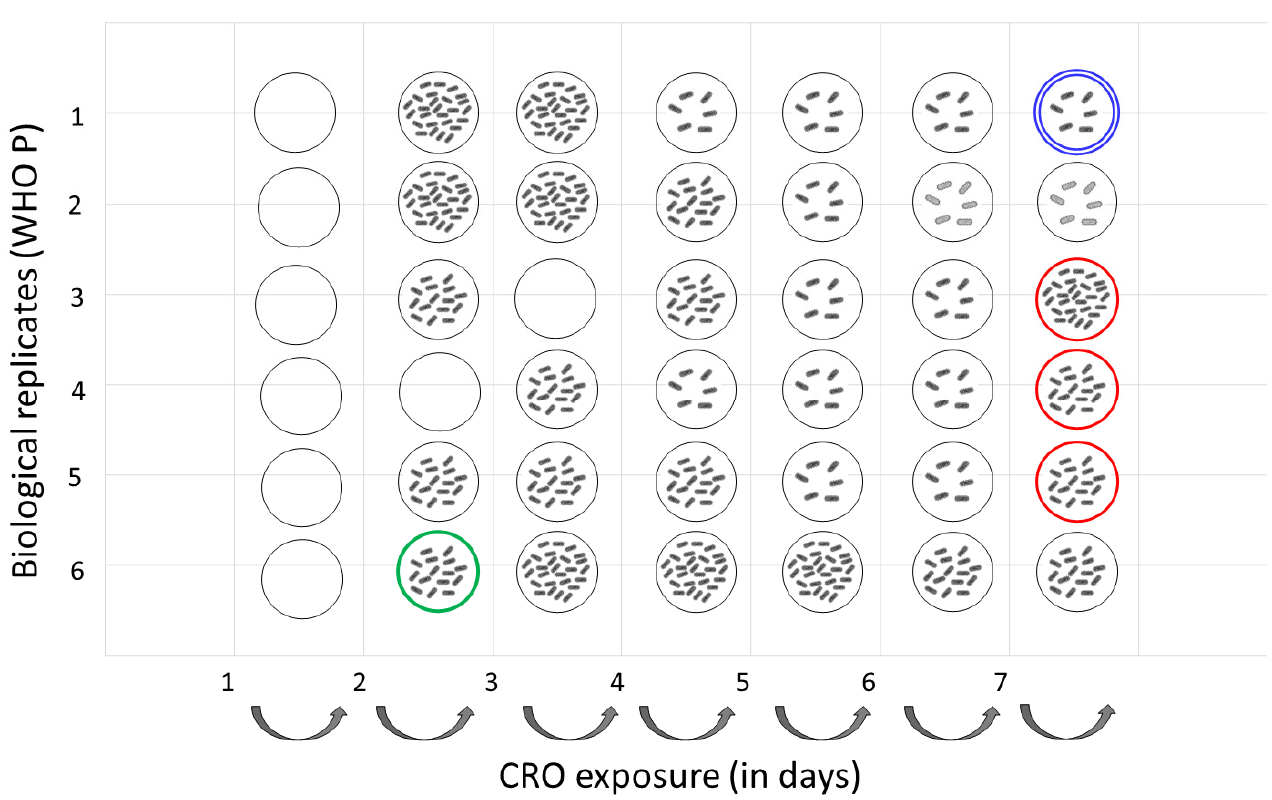
Figure 2. Ceftriaxone tolerance evolution of N. gonorrhoeae WHO P strain (n = 6) after 3 h 10 × MIC cyclic exposure to CRO. Tolerance was determined using TD test. TD test results were categorized as follows: low tolerance (1–10 colonies), medium tolerance (10–20 colonies) and high tolerance (>20 colonies). Double halo (growth around inhibition zone) is depicted in light gray (Time point 6 and 7 of lineage 1). Red and green circles denote isolates with mutation in eno and C7S06_RS11330 genes, respectively. Blue circle denotes isolates with mutations in tatC and edd genes. Empty circle denotes no tolerant isolates.